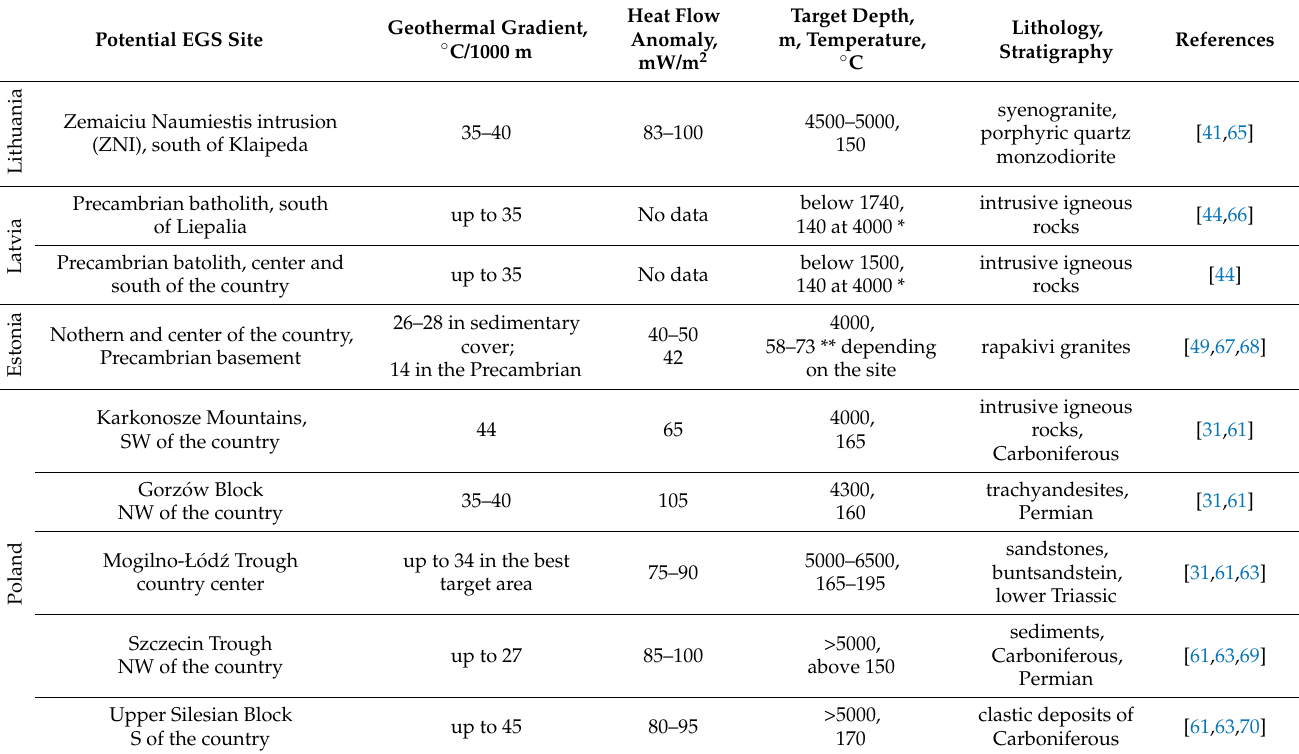
Figure 7. Prospective areas for conventional and unconventional geothermal energy utilization and Earth’s heat flow density in Poland against the background of simplified geologic setting (based on [31,61,64]). Table 2. Selected parameters of the potential EGS sites in the countries of the south-east Baltic basin .